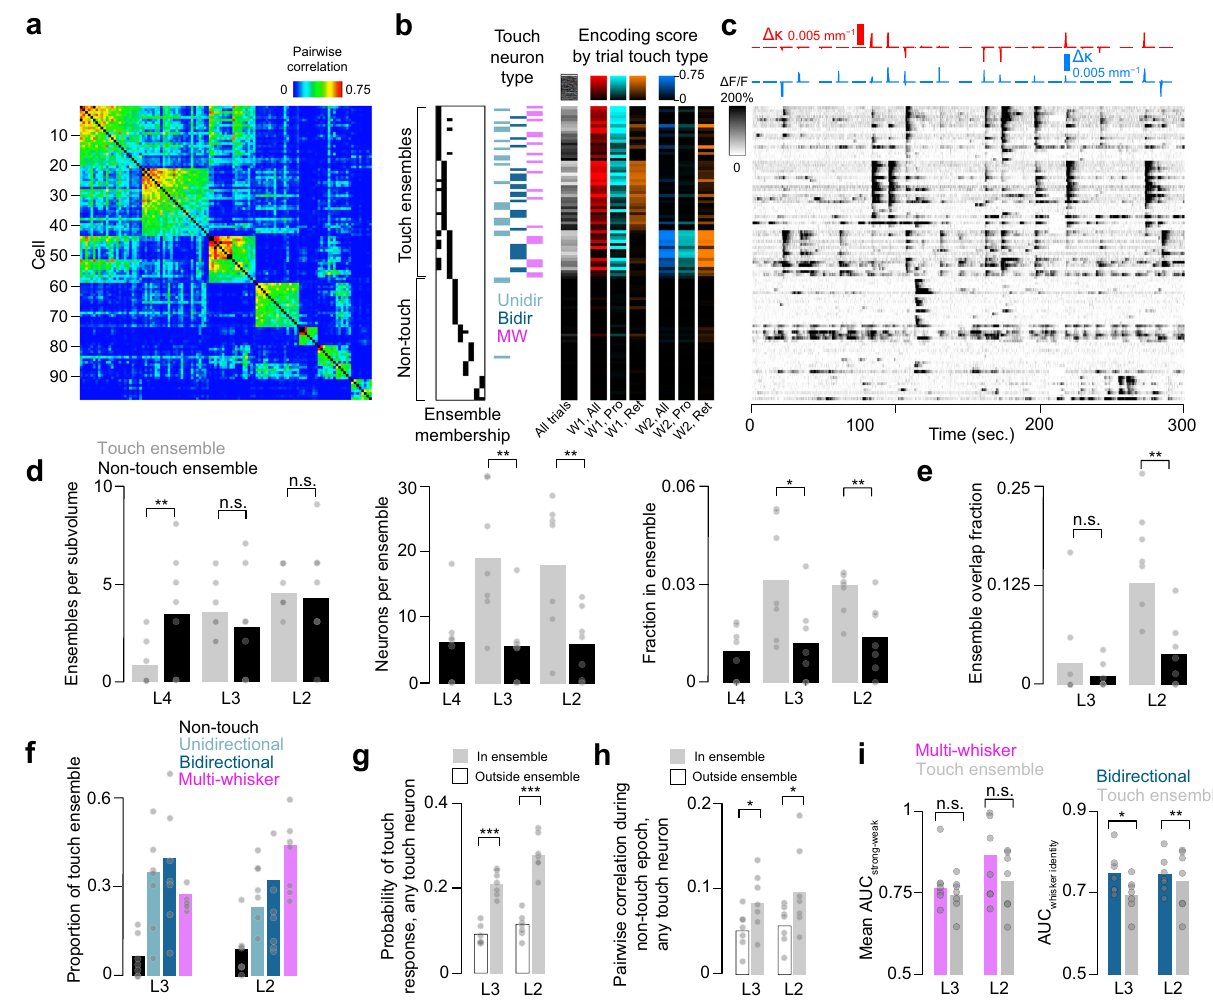
Fig.7|Ensemblesandtheirroleintouchresponses.a Pairwisecorrelationmatrix forensembleneuronsinL2of anexamplemouse(Methods).Ensemblesaresorted by mean within-ensemble correlation. b Classi fi cation of ensemble members. Left, assignment of each neuron to a particular ensemble. Middle, neural type. Right, encoding scores forgiventrialtypes. c Δ F/Fforthe neurons in a , b overthe course of 5min. Top, Δκ for whisker 1 (red) and whisker 2 (blue). d Basic properties of ensembles across layers. Left to right: ensembles per subvolume; number of neu- rons per ensemble; fraction of neurons belonging to an ensemble. Grey, touch ensembles. Black, non-touch ensembles. Bars indicate mean ( n =7 mice). P -values